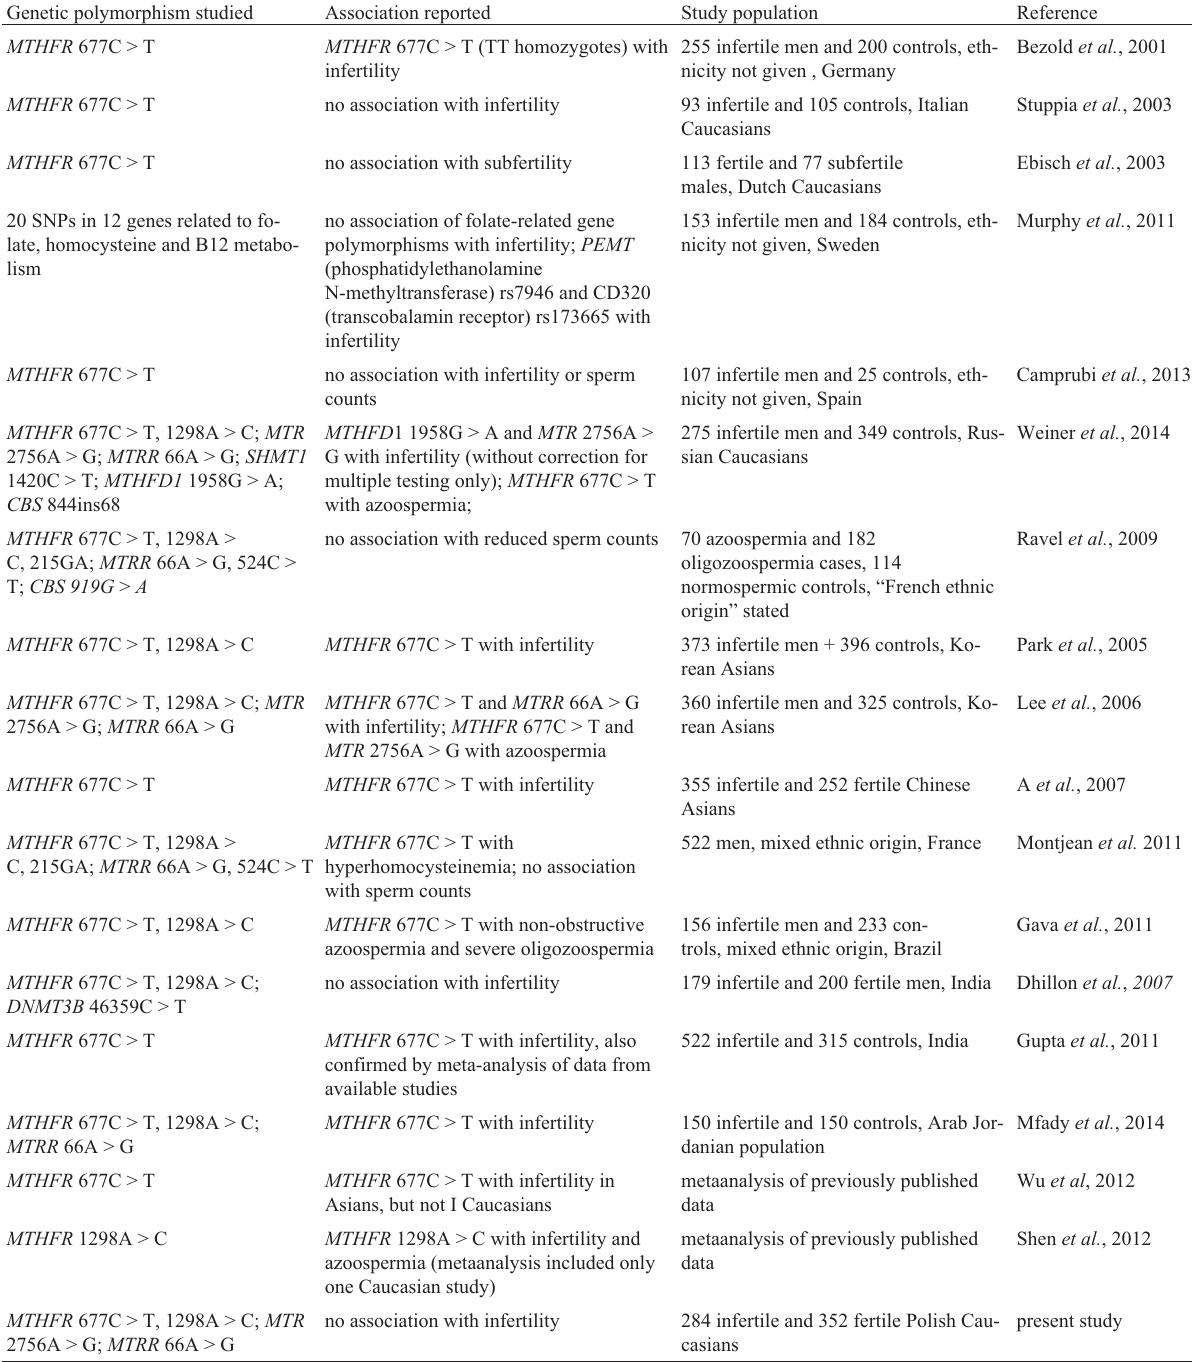
Table 2 - Previous studies on genes of folate-mediated one-carbon metabolism pathway in relation to male